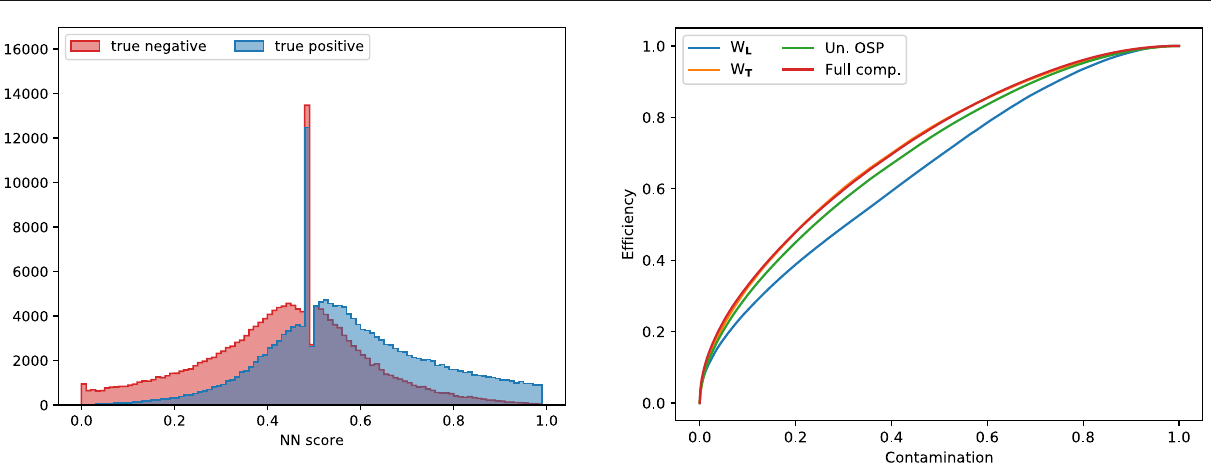
Fig. 8 ROC curves in the semi-leptonic channel, representing the frac- tion of correct positive solution choices (efficiency) versus the frac- tion of negative solutions falsely labeled as positive (contamination), obtained on PHANTOM samples containing a purely longitudinally polarized (W L ) leptonically decaying W boson, a purely transversely polarized (W T ) boson, an unpolarized W boson generated in the OSP PHANTOM framework(Un.OSP)andthefullcomputationwithanunpo- larizedWbosonandwithnon-resonantproductionmodesincluded(Full comp.) are shown. The optimal working point is defined as the thresh- old giving the shortest distance to point (0,1). The W T result coincides almost fully with the Full comp. and is consequently not visible in the plot